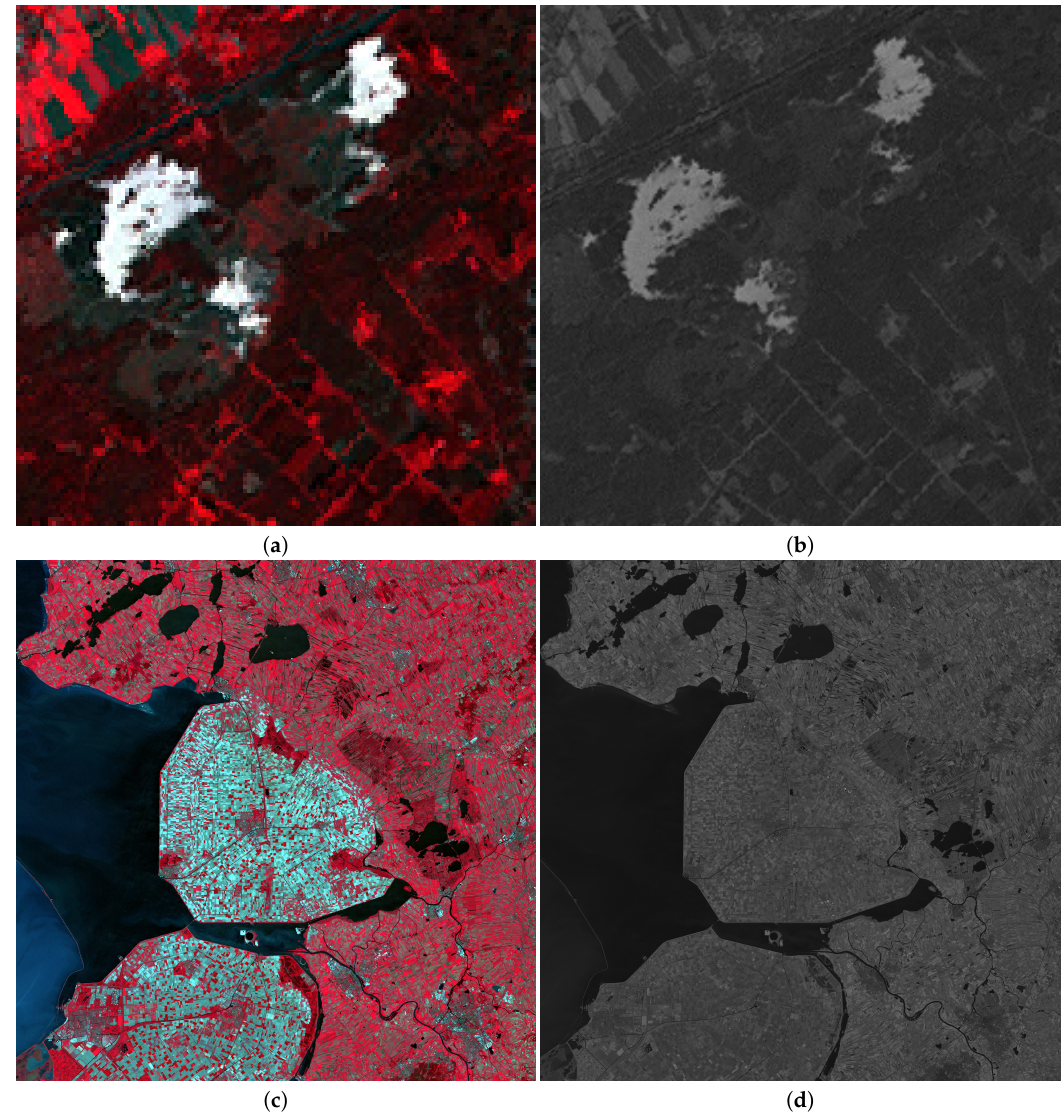
Figure 2. Observed LANDSAT 7-ETM+ Netherland images: ( a ) 128 × 128 MS, ( b ) 256 × 256 PAN, ( c ) 2048 × 2048 MS, ( d ) 4096 × 4096